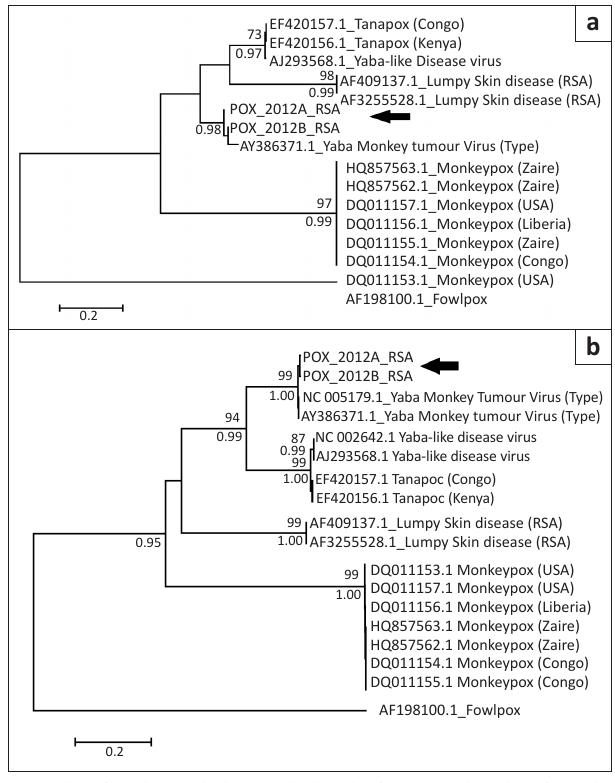
FIGURE 4 : Neighbor-joining tree inferred from partial (a) insulin metalloprotease- like protein gene and intracellular mature virion membrane protein gene and (b) DNA polymerase sequences of pox isolates of skin biopsies from an adult vervet monkey female from South